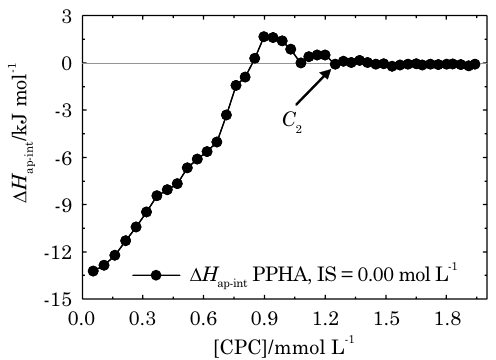
figure 2. apparent molar enthalpy change (∆ H ap-int ) of interaction between Pahokee peat humic acid (PPha) and hexadecylpyridinium chloride monohydrate (cPc) surfactant in carbonate buffer at 25 o c and 0.00 mol L -1 ionic strength